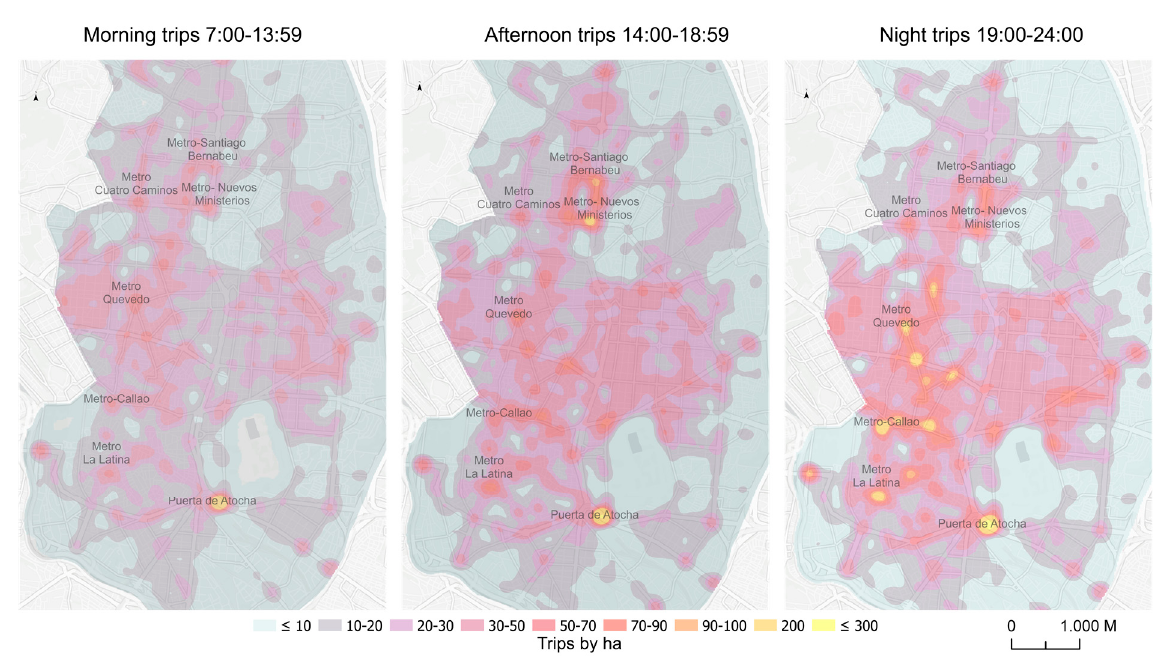
Figure 5. Density of trips (origins) by hectare and time bands.